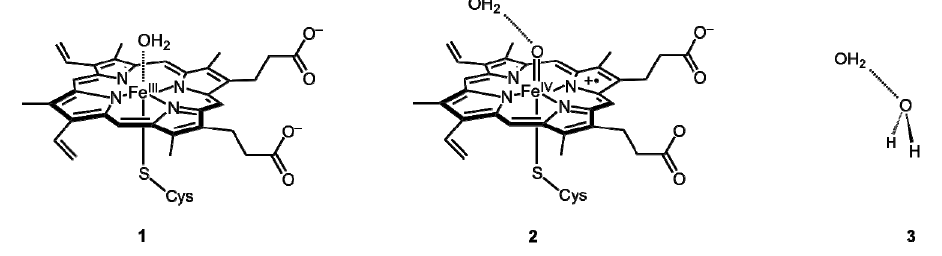
Figure 1. Resting state ( 1 ), water-bound Cpd I ( 2 ), and water dimer ( 3